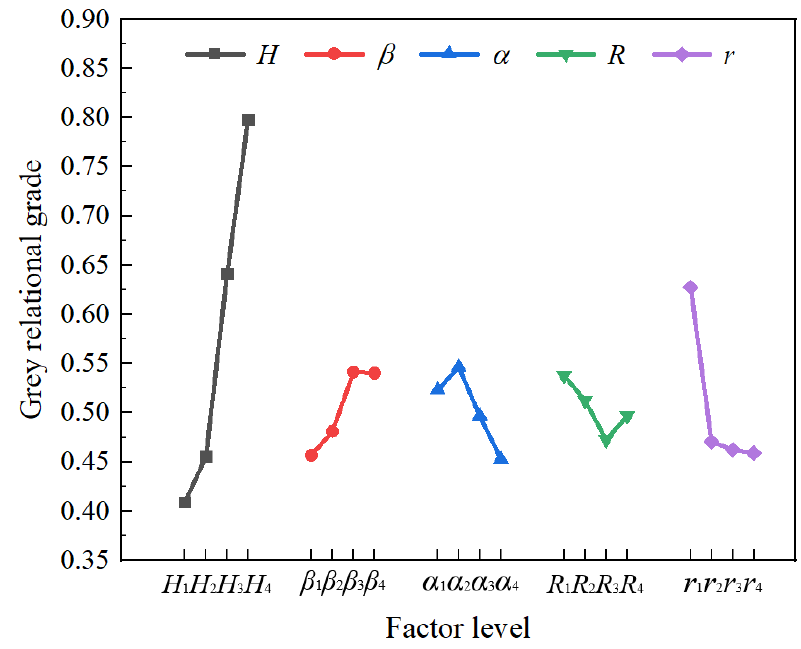
Figure 11. Effect of factor level on multi-objective